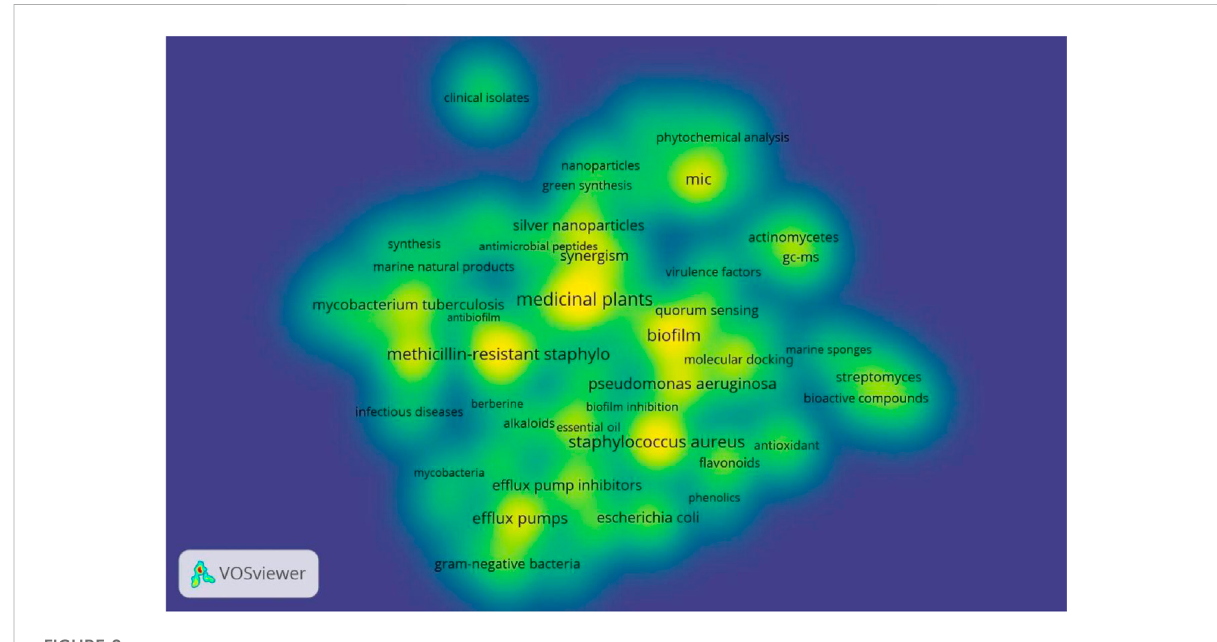
FIGURE 8 Density visualization map of keywords related to resistance of natural products to MDR bacteria.